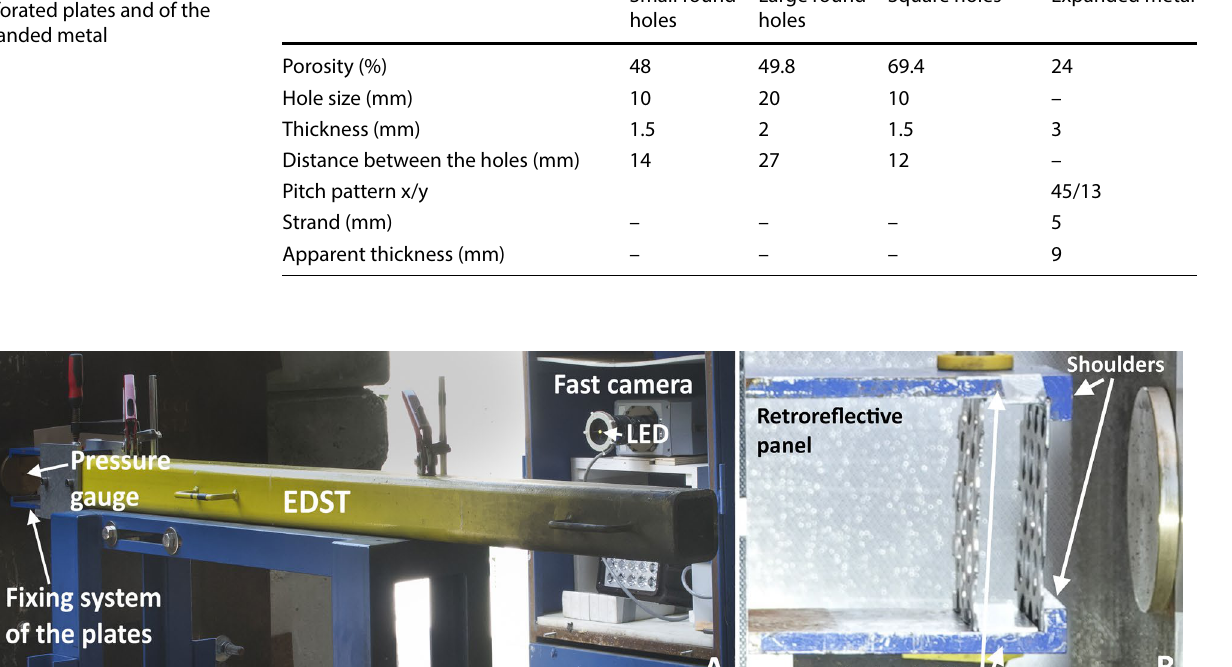
Table 1 Characteristics of the perforated plates and of the expanded metal